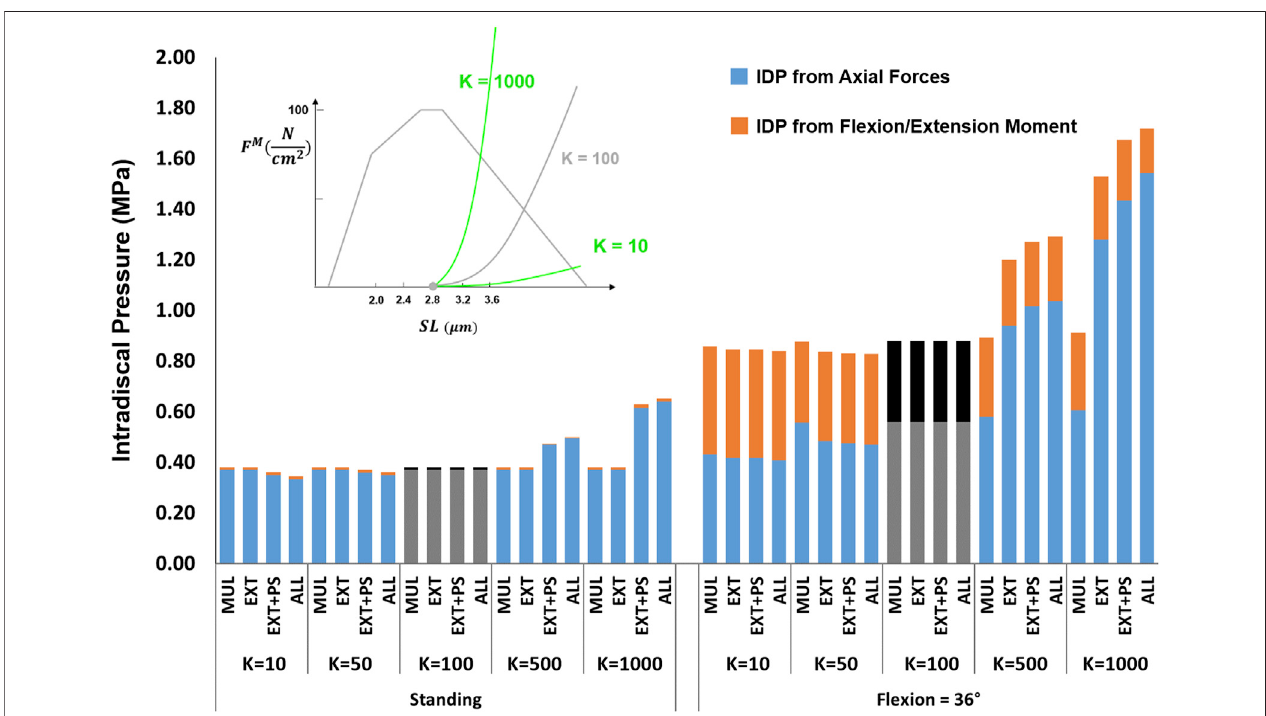
FIGURE6| Theeffectofdifferentpassiveforce-lengthcurvescalingconstants(Kin N applied to multi fi dus (MUL), extensor muscles (EXT), extensor muscles, and psoas (EXT + PS), and all 210 muscles in the model (ALL). Grey/black bars represent the baseline